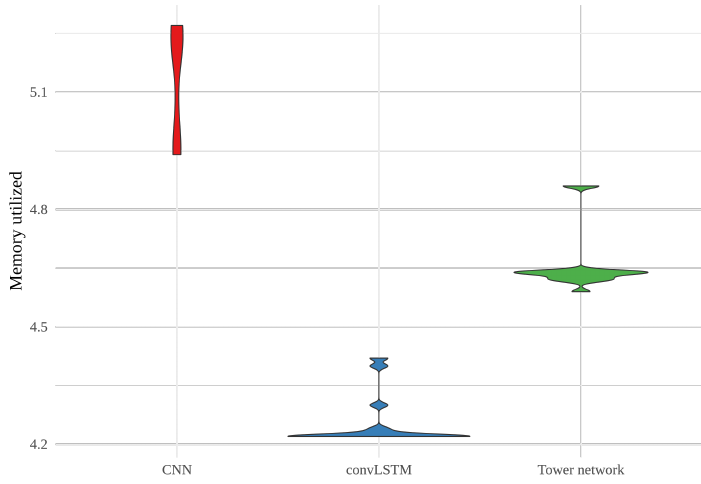
Figure 11. Violin plot of the memory (in GB) utilized when training the models. Each violin represents the memory usage of 15 realizations of a model. From the left, there is CNN in red, convLSTM in blue and the tower network in green.